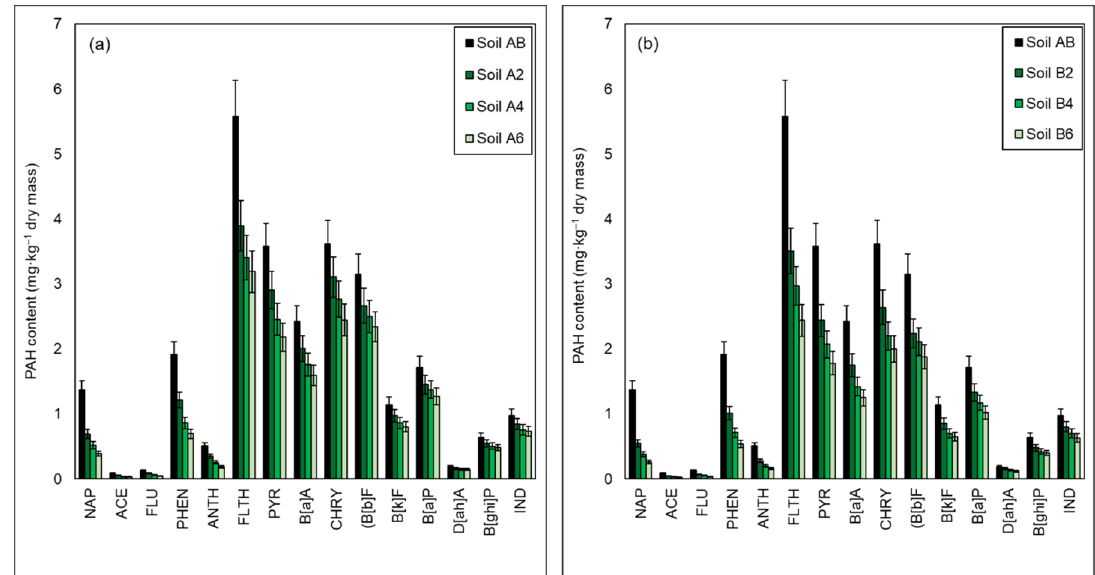
Figure 5. Residual content of PAHs in soil contaminated petroleum hydrocarbons inoculated ( a ) biopreparation A1, ( b ) biopreparation A1 with the addition of γ -PGA after 2 (Soil A2/Soil B2), 4 (Soil A4/Soil B4) and 6 (Soil A6/Soil B6) months of the biodegradation process carried out in ex-situ conditions. Control was non-inoculated Soil AB. (repetition number n = 7–10, p < 0.05). (naphthalene (NAP),